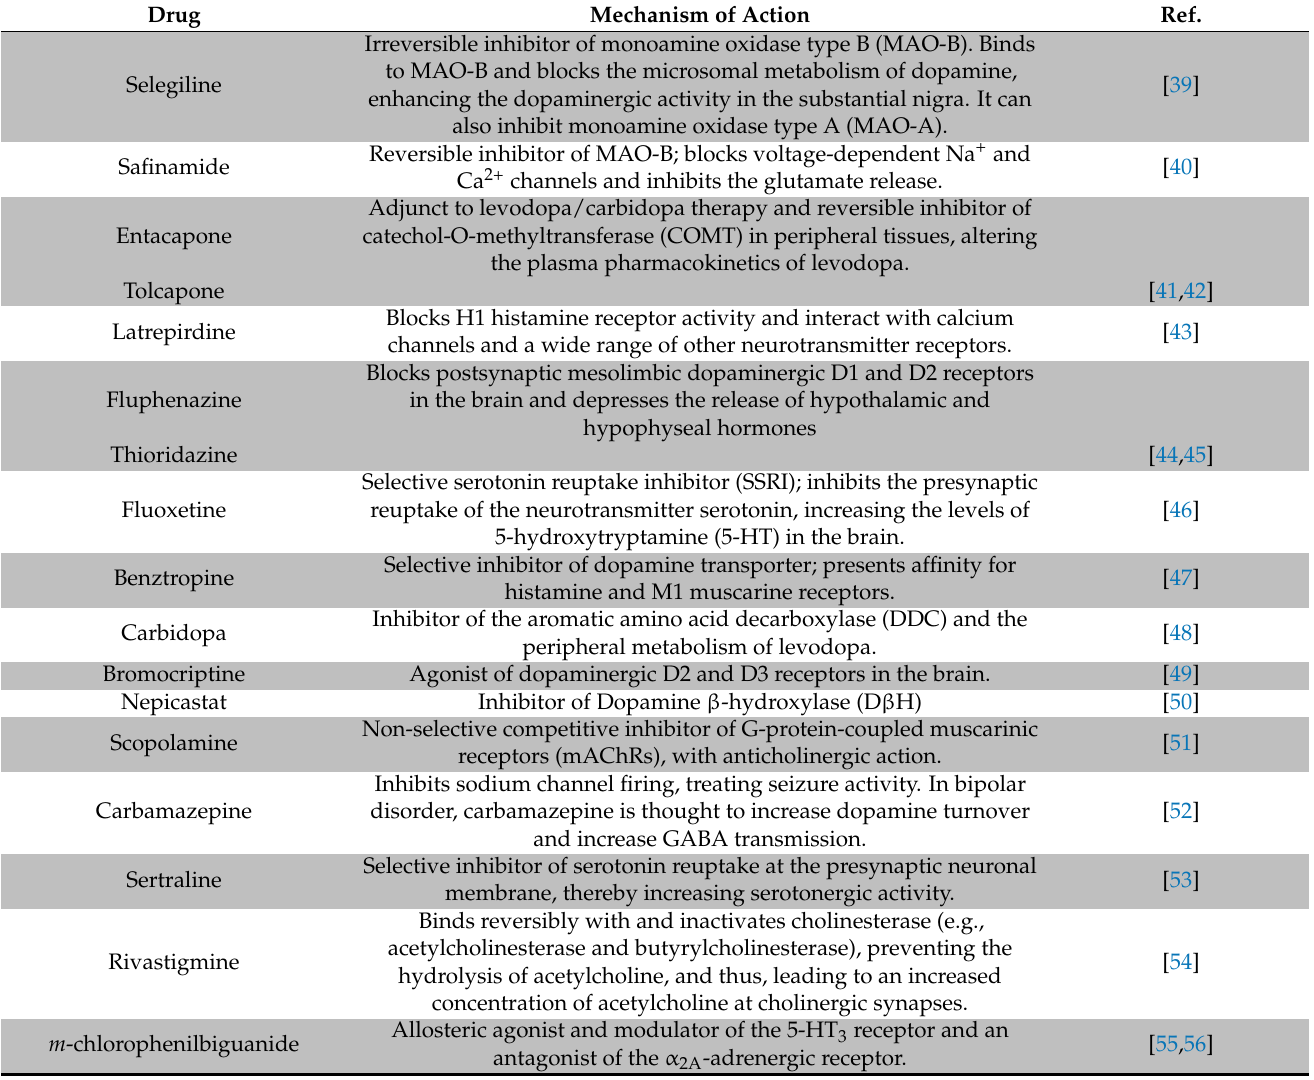
Table 1. CNS drugs used in this work and their mechanism of